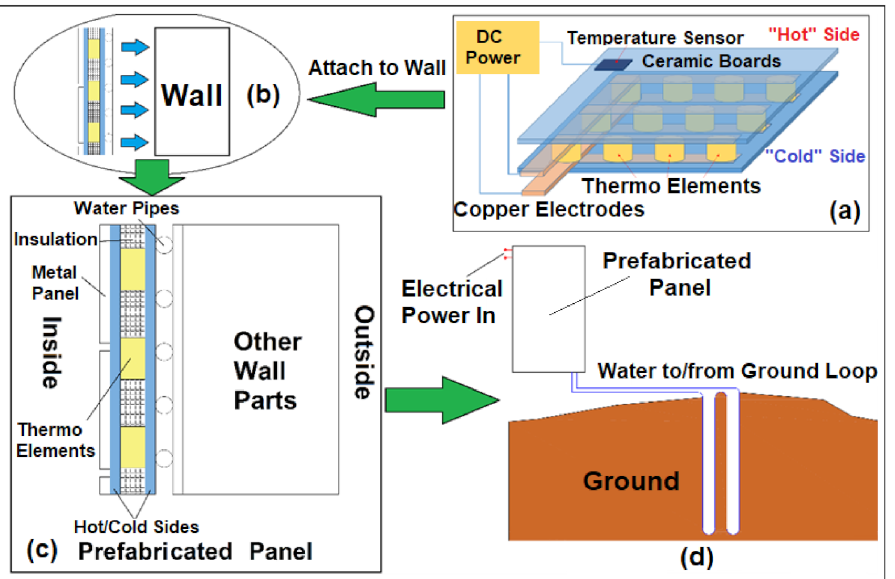
Figure 1. Novel, panelized, ground source, radiant heating and cooling system design for building applications: ( a ) schematic drawing of the structure of proposed heating/cooling panel, ( b ) attach- ment to building envelope component, ( c ) section view of the prefabricated panel, and ( d ) connection to the ground